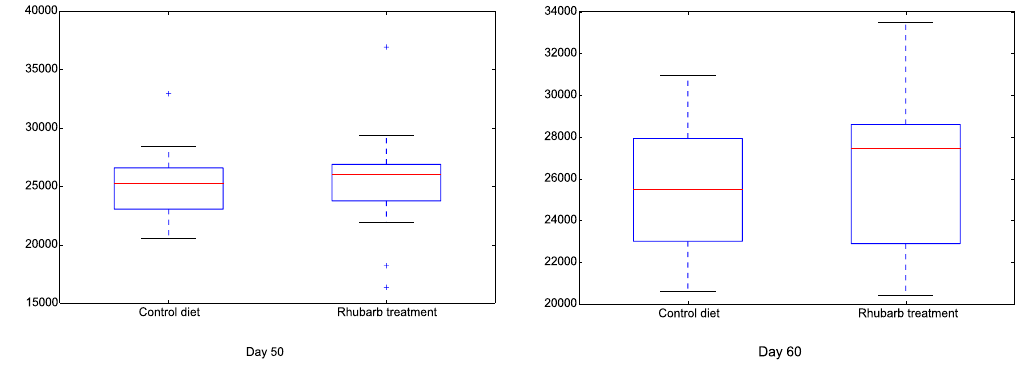
Figure 2. Comparison of Chao 1 index of methanogen communities between control diet treatment and rhubarb supplementation treatment on 50 d and 60 d. The horizontal lines in each box indicate the median values, and the 75 th and 25 th quartile values are respectively represented by the top and bottom sides of each box.